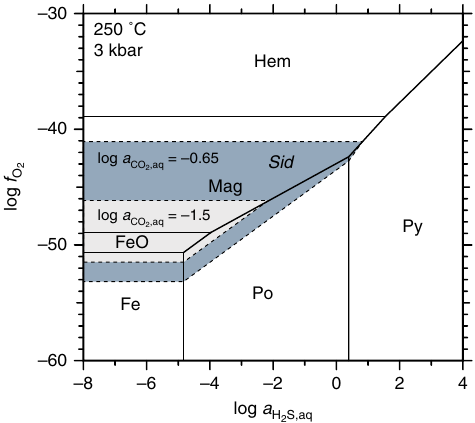
Fig. 9 Thermodynamic stability of magnetic signal carrier minerals. H 2 S – O 2 activity diagram in the system Fe – O 2 – H 2 S showing the stability of native iron, iron oxide and iron sul fi de phases as a function of fl uid H 2 S activity and oxygen fugacity. The shaded areas indicate stability of siderite over native iron, iron oxide and iron sul fi de phases at fl uid CO 2 activities corresponding to soapstone (gray fi eld) and listvenite (dark gray fi eld) formation (hexagon symbols in Fig. 3). The magnetite stability fi eld is signi fi cantly reduced relative to siderite at a fl uid CO 2 activity that stabilizes the listvenite assemblage. The diagram was calculated using the computer program Supcrt and thermodynamic database dprons96.dat 50 . The same diagram calculated for alteration temperatures of 180 °C and 300 °C is included in the supplement (Supplementary Fig.